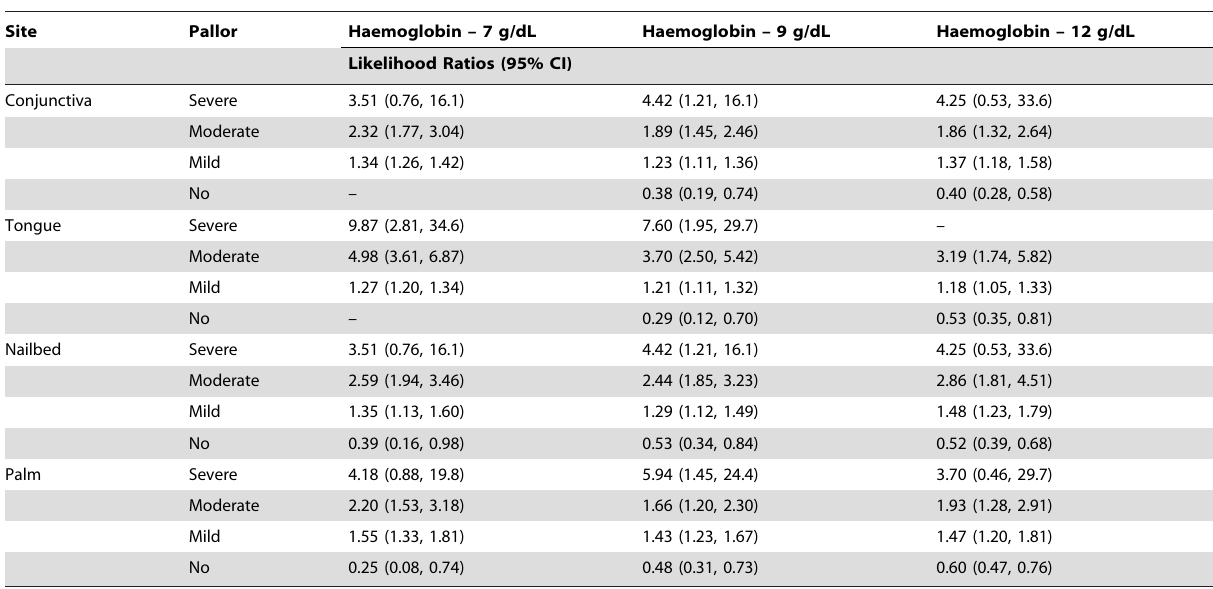
Table 2. Likelihood ratios (LR) for pallor grades in diagnosing